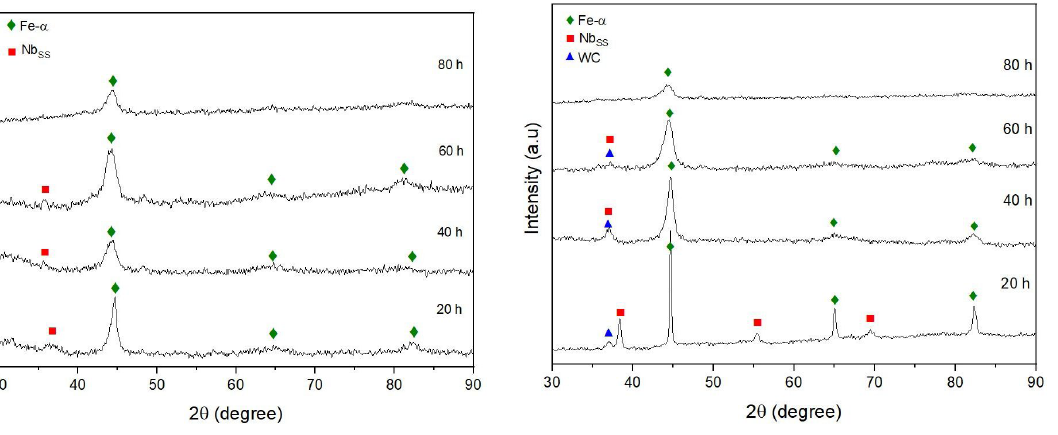
Figure 13. Fe-15at.%Nb sample diffractogram after milling with hexane PCA.